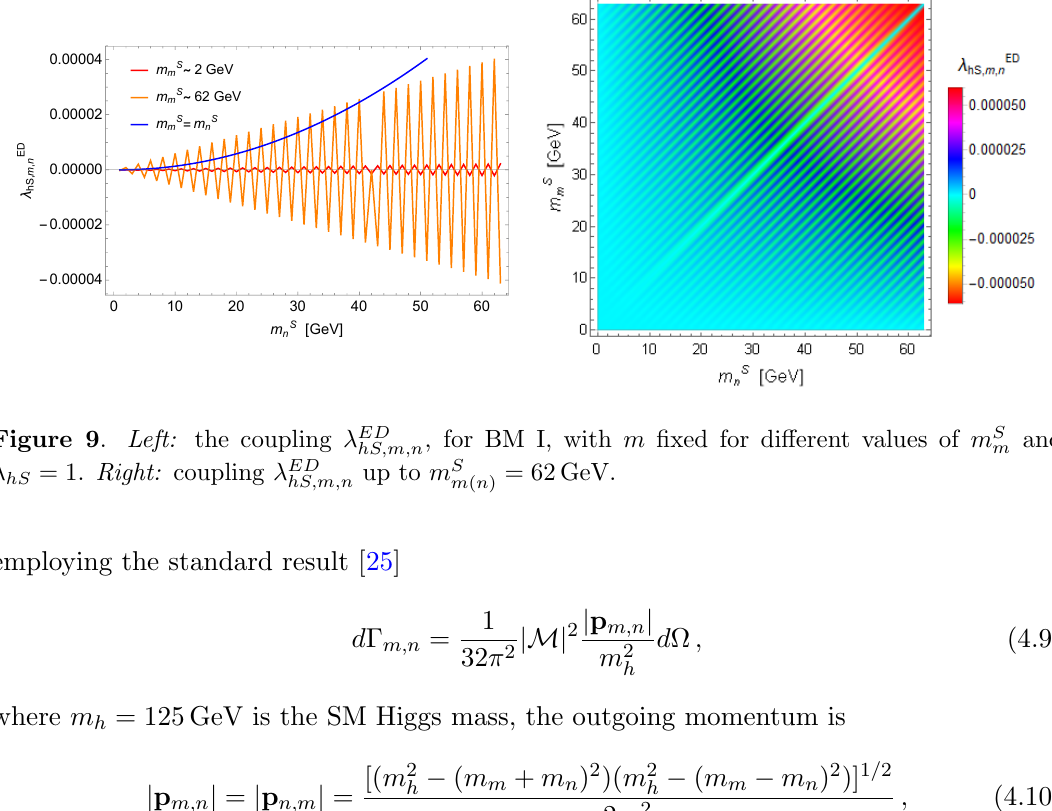
Figure 8 . Higgs portal couplings as a function of x S but with the other parameters unchanged, for BM I (top) and BM II (bottom).